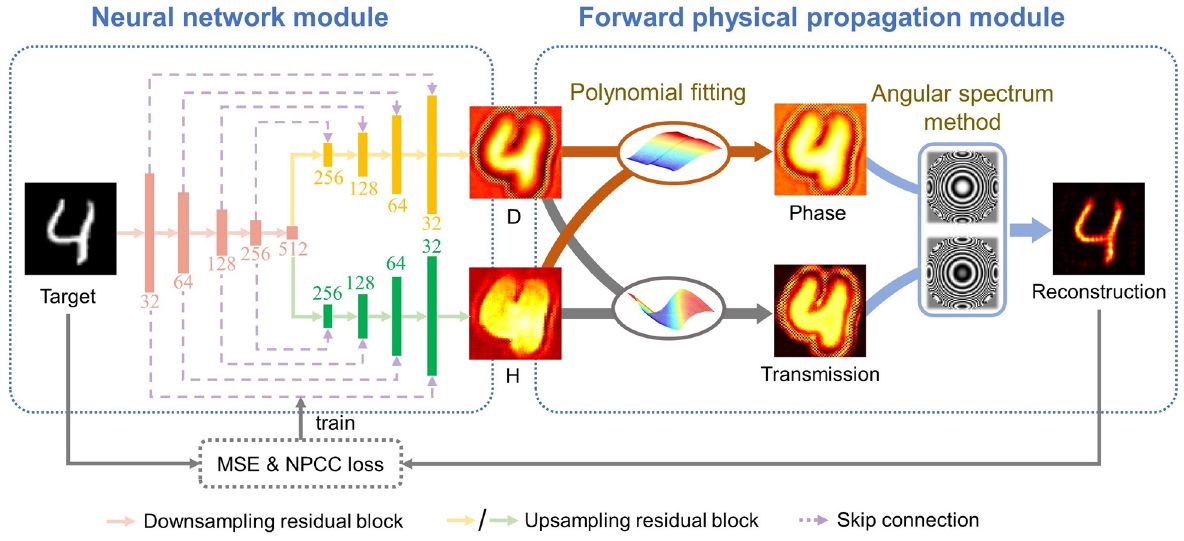
Figure3: Architectureofthenetworkwithcooperationoftwomodules,i.e.,neuralnetworkmoduleandforwardphysicalpropagationmodule. Theoutputimageofforwardphysicalpropagationmoduleisreconstructedtothesamepatternasthetargetimagetoobtainthediametermap and the height map of nanocylinder